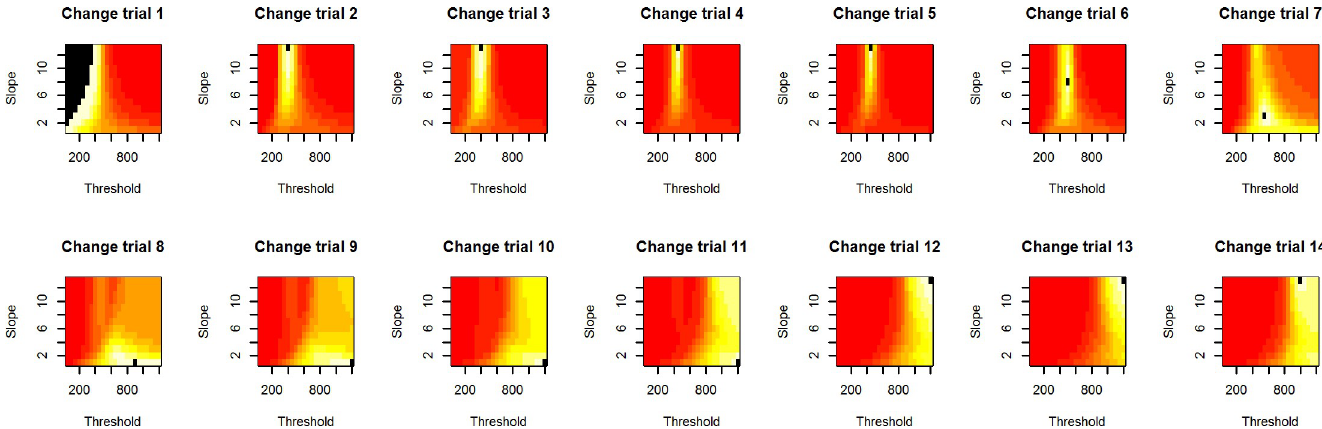
Fig 2. Likelihood estimates during Experiment 1. The PSI marginal method’s posterior distributions for the example participant. Probabilities are averaged over the error rate dimension, colors indicate the probability of a parameter combination, the point of maximum probability is indicated in black. Colors range from minimum to maximum probability per distribution. Around Change-trial 9, the most likely threshold parameter reaches the boundaries of the method’s parameter space.